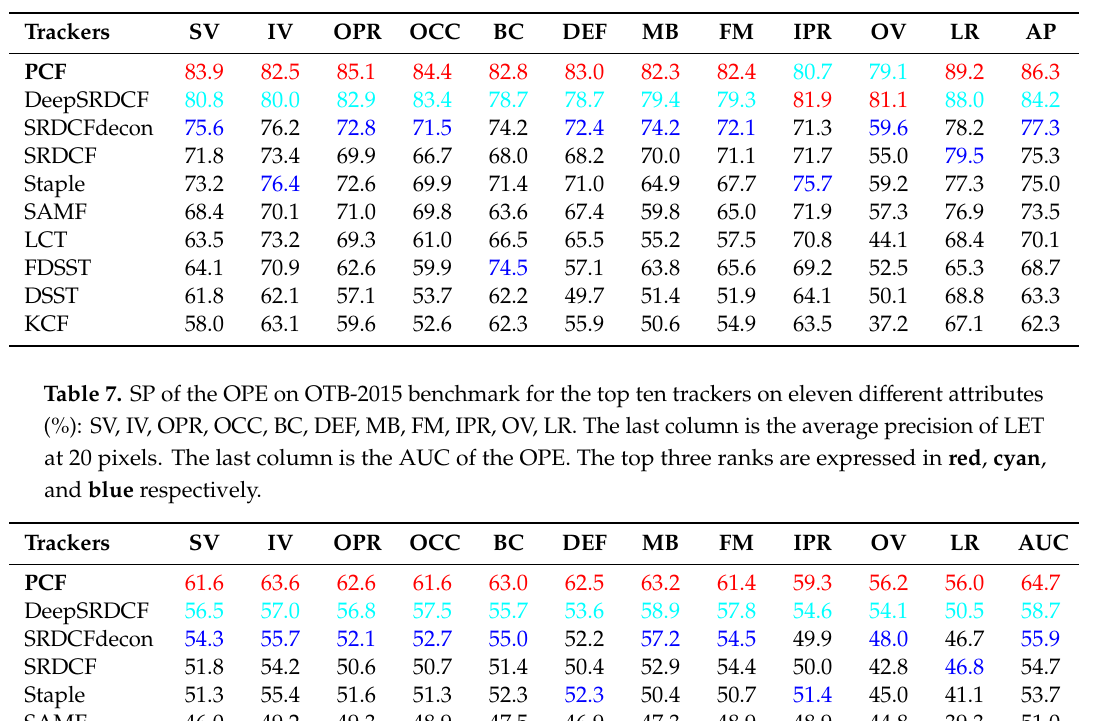
Figure 11. The comparing results for the top ten trackers with the entire 100 videos on the OTB-2015 benchmark: ( a ) The PP of the OPE on all videos; ( b ) The SP of the OPE on all videos. Table 6. The PP of the OPE on the OTB-2015 benchmark for the top ten trackers on eleven different attributes (%): SV, IV, OPR, OCC, BC, DEF, MB, FM, IPR, OV, LR. The last column is the AP of LET at 20 pixels. The top three ranks are expressed in red , cyan , and blue respectively.